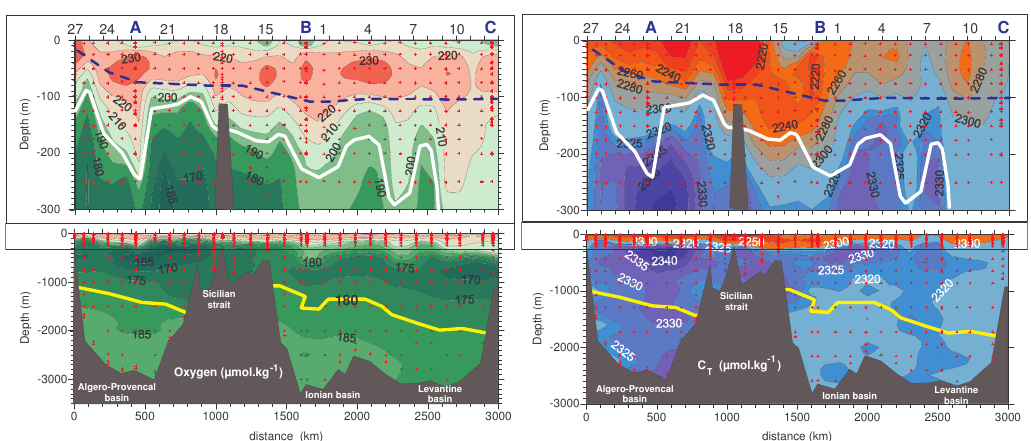
Figure 2. Surface (top) and total water column (bottom) vertical sections of A. oxygen concentration and B. Carbon inorganic total concentration (C T ) along the BOUM transect. The white full line in surface section illustrates the limit of 195 µmol kg -1 in oxygen between the Biogenic Layer (BL) and the Mineralization Layer (ML). The blue dashed line follows the depth of the deep chlorophyll maximum (full section is presented in Crombet et al., This issue). The yellow full line in the deep section illustrates the limit of 180 µmol.kg -1 in oxygen between the ML and the Deep Layer (DL). See text for further explanation. On the top X-axis, the position of the stations is indicated.